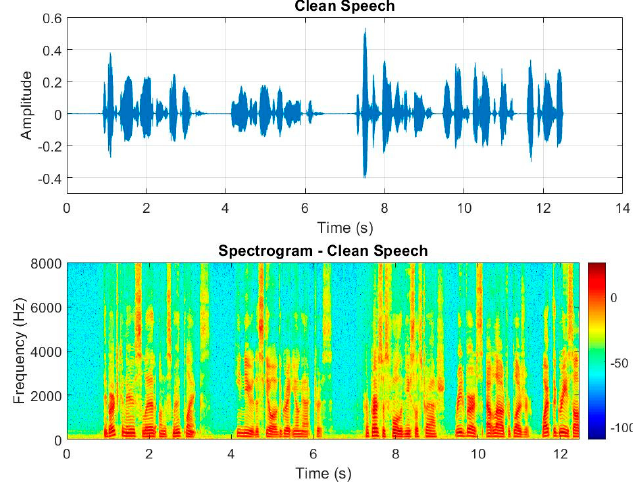
Figure 9. The time-domain and spectrum for the male speech signal.